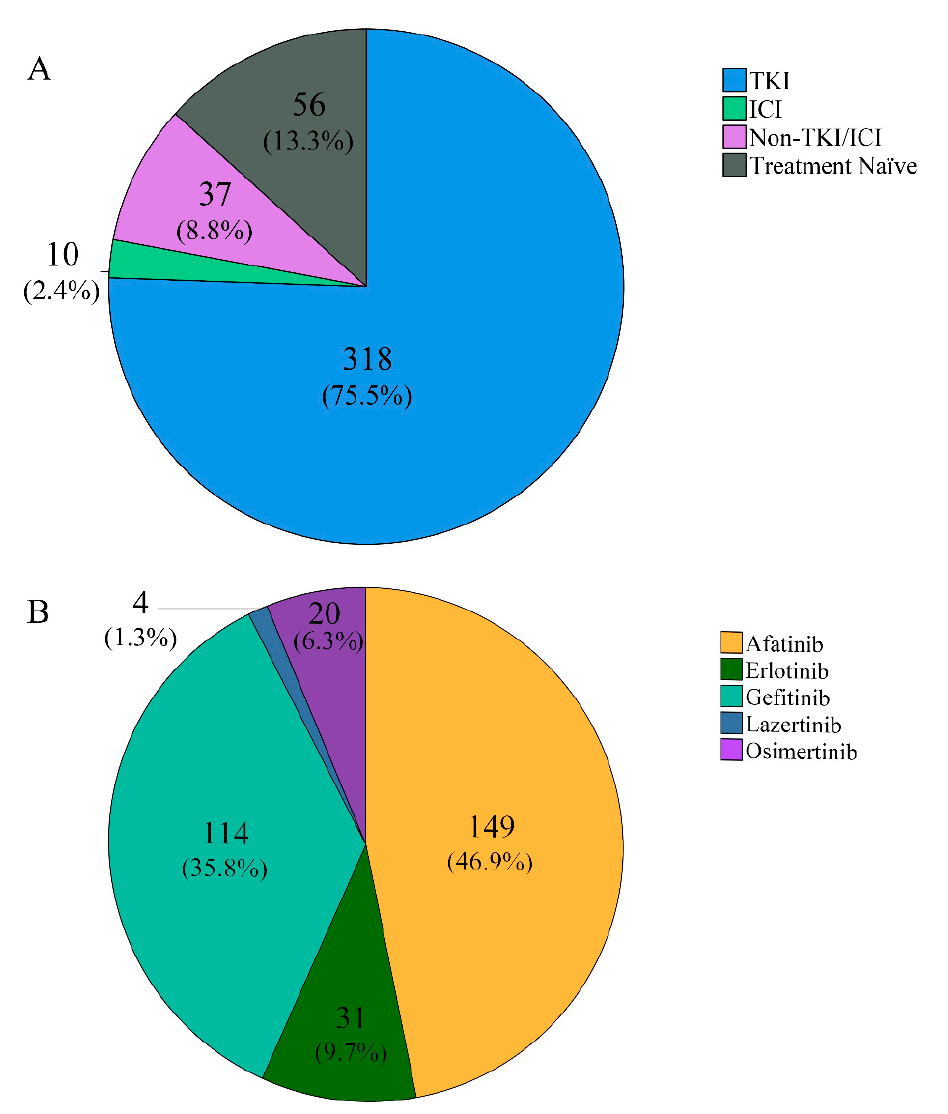
Figure 2. The type of treatment performed in 421 cases ( A ), and the type of tyrosine kinase inhibitor (TKI) administered in 318 cases who underwent TKI treatment ( B ). A total of 318 cases (75.5%) underwent TKI treatment before ctDNA analysis. Among the cases with TKI treatment, the most commonly used regimen was afatinib (149 cases, 46.9%), followed by gefitinib (114 cases, 35.8%), erlotinib (31 cases, 9.7%), osimertinib (20 cases, 6.3%), and lazertinib (4 cases, 1.3%).